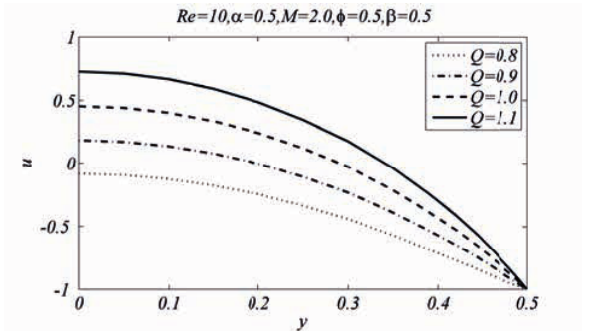
Fig. 6: Comparison of longitudinal velocity for different values of M (a) Newtonian (b) Non-Newtonian